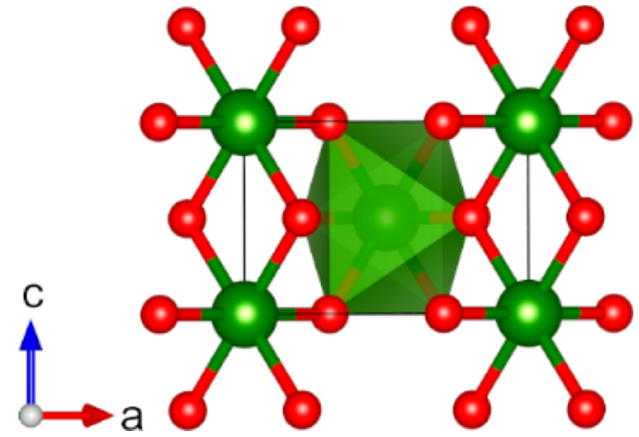
Figure 4. Optimized structure of CrO 2 ( tP6 ) (red: O, green: Cr). Spins are aligned along c axis and not visualized. Coordination octahedron of Cr is shown in green